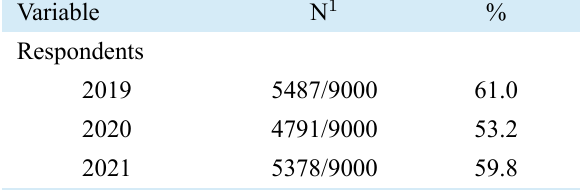
TABLE 1. Rate of Korean adult males’ regular participation in sports activities by year